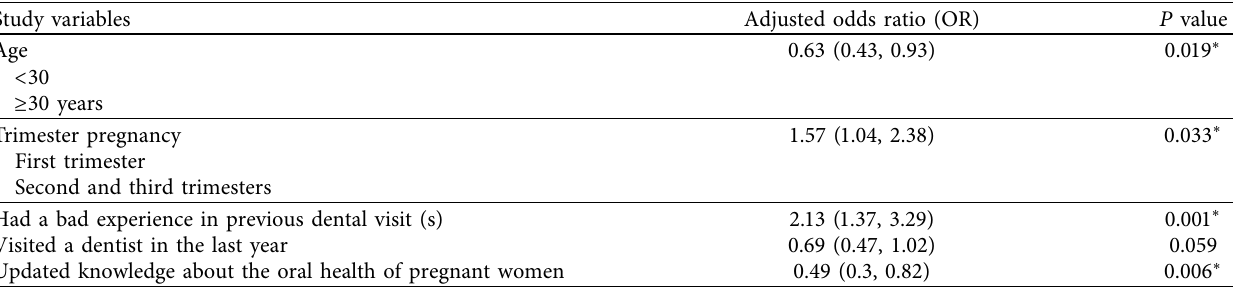
Table 4: Multiple logistic regression final model (backward stepwise LR): association between various factors and dental phobia in pregnant women.